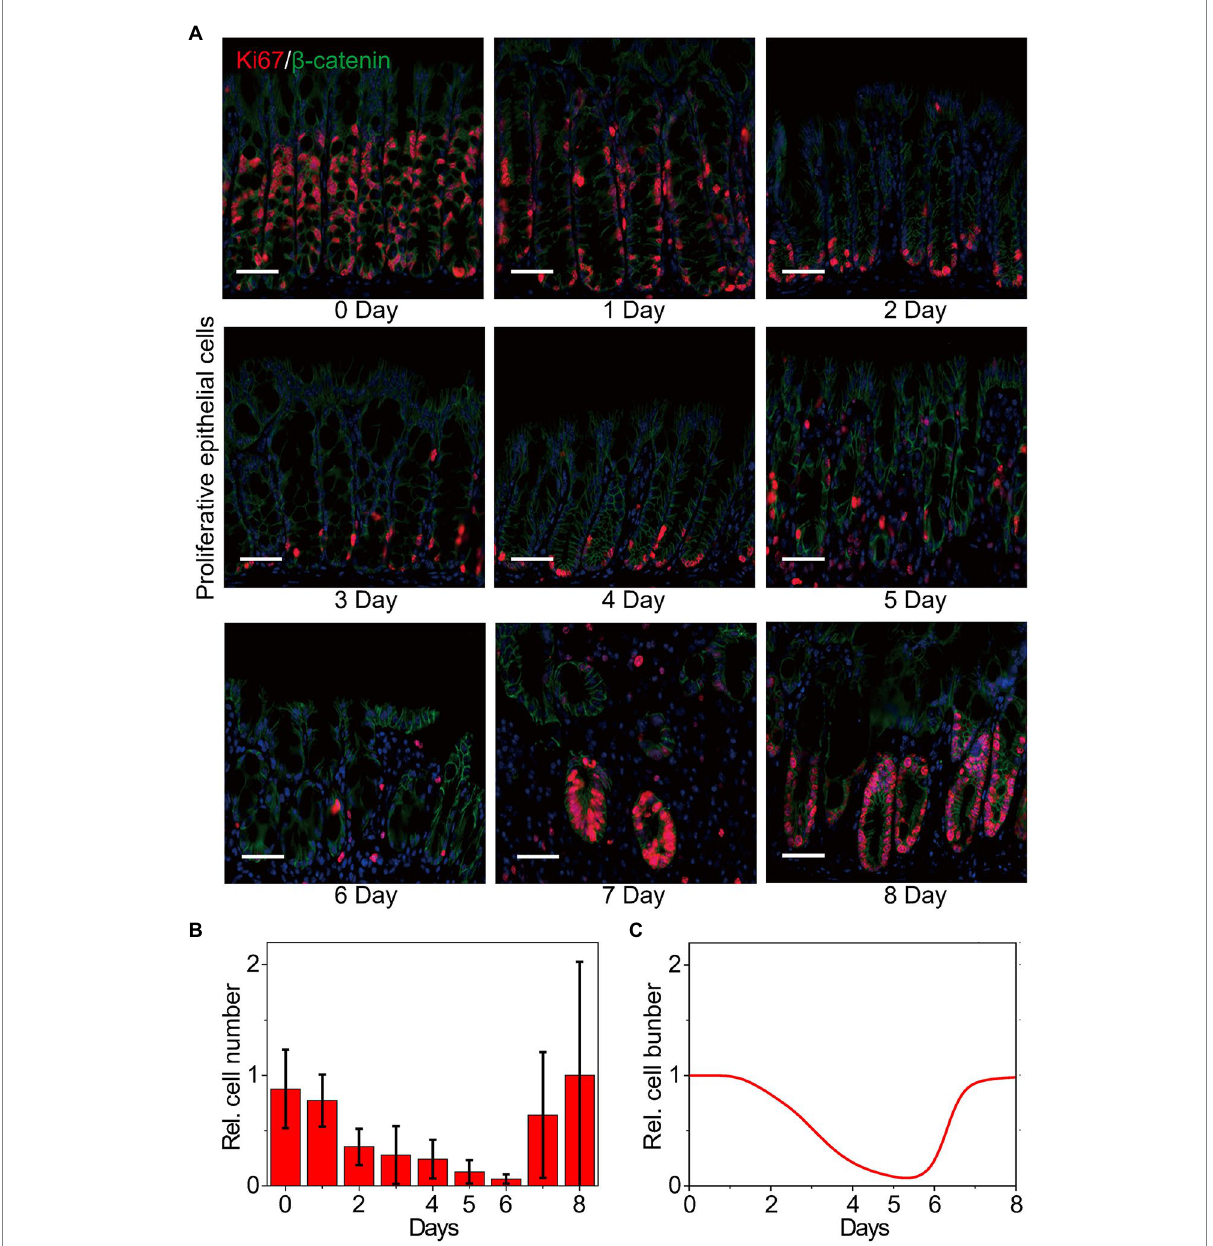
FIGURE 3 Dynamics of the number of proliferative epithelial cells. (A) Double immunofluorescence for Ki67 and β -catenin in colons from WT littermates at the indicated time points following DSS treatment. n = 3 at each time point. (B) Statistical histogram of experimental results for the proliferative cell number in panel (A) . (C) Simulation results of the proliferative cell number in WT model over time after DSS treatment. Here, the cell numbers of proliferative epithelial cells are normalized by the maximum